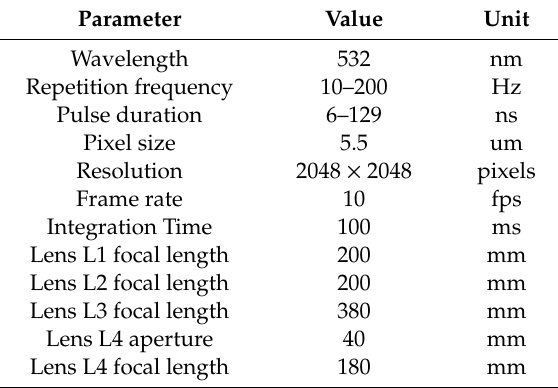
Table 1. System parameters for MFI imaging.